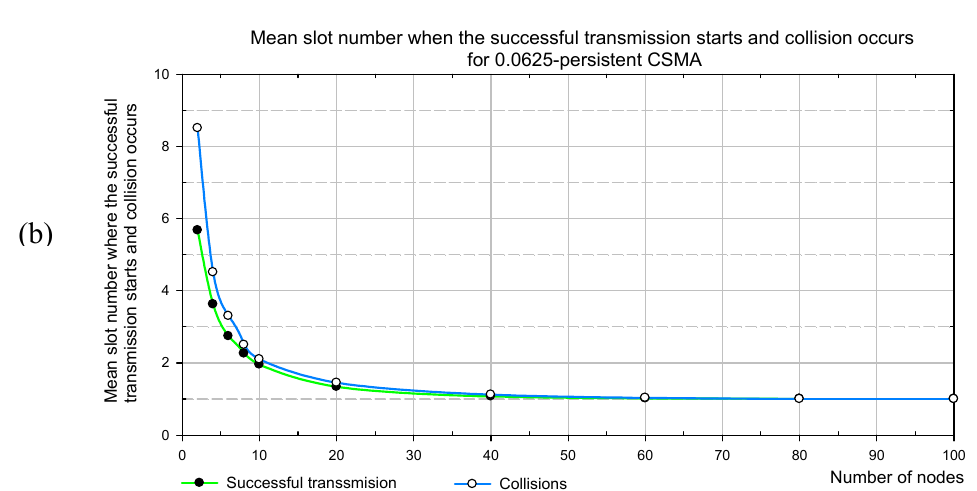
Figure 3. Probabilities of successful transmission )( )1( np numbers where the successful transmission starts )( )1( nd